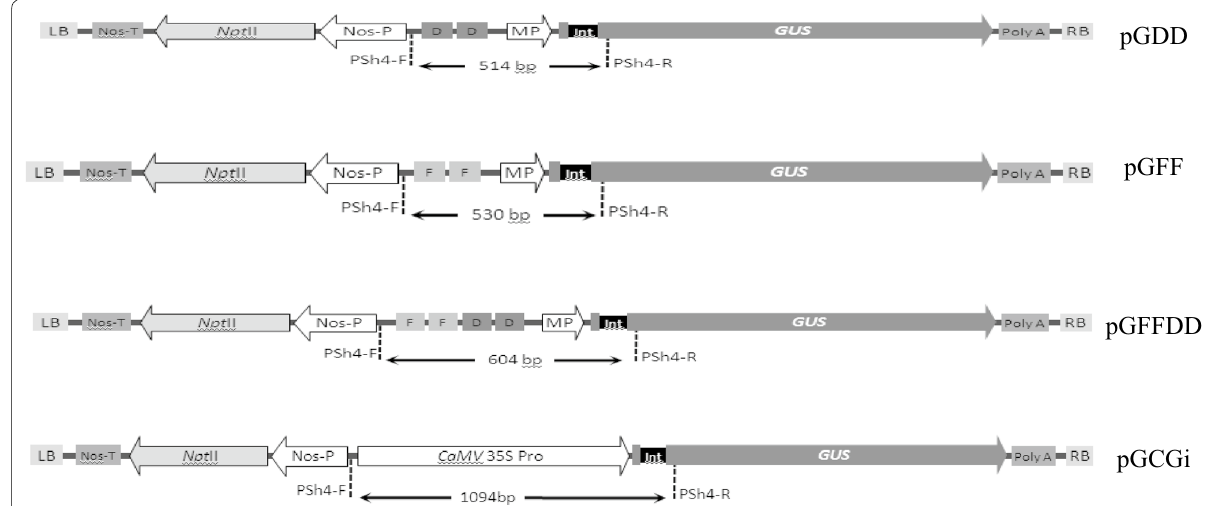
Fig. 1 Schematic representation of T-DNA region in constructed synthetic promoters. pGDD, pGFF, and pGFFDD contain two repetitions of D element, two repetitions of F element and two repetitions of F and D elements which are located upstream of CaMV 35S minimal promoters, respectively. LB: left border, Nos-T: nopaline synthase terminator, Npt II: neomycin phosphotransferase II, Nos-P: nopaline synthase promoter, FF: dimer of the F cis -acting element, DD: dimer of the D cis -acting element, MP: sequence of promoter, GUS: β ‑ glucuronidase containing intron, Poly A: poly adenylation tail, RB: right border. A pGCGi construct contains CaMV 35S promoter used as positive control